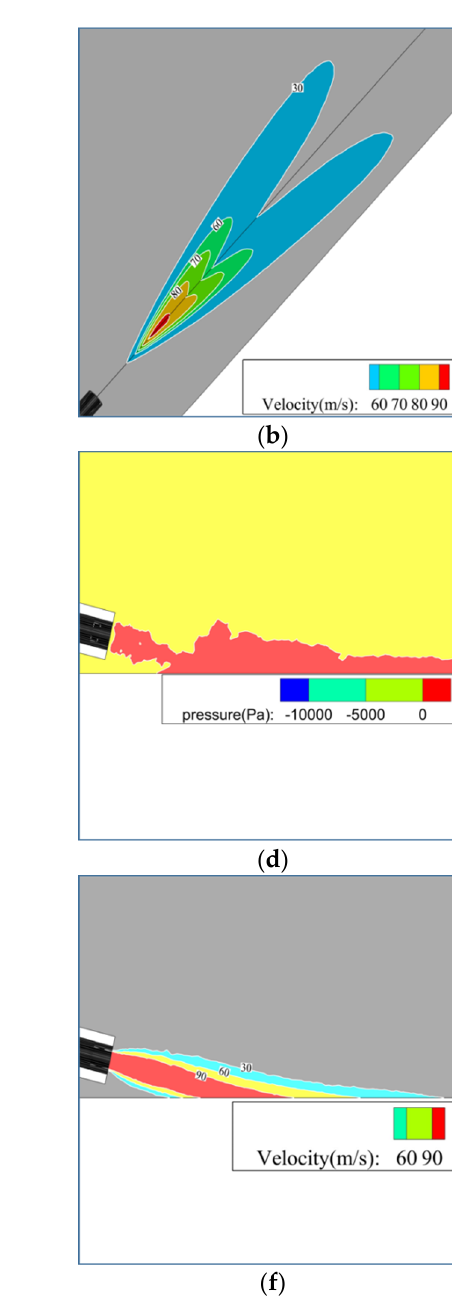
Figure 6. ( a ) O 2 concentration distribution on the upper and right surfaces of casting slab; ( b ) velocity on the upper and right surfaces of casting slab; ( c ) pressure on the upper and right surfaces of casting slab; ( d ) pressure at 45° section of nozzle center; ( e ) O 2 concentration distribution at 45° section of nozzle center; ( f ) velocity at 45° section of nozzle center.